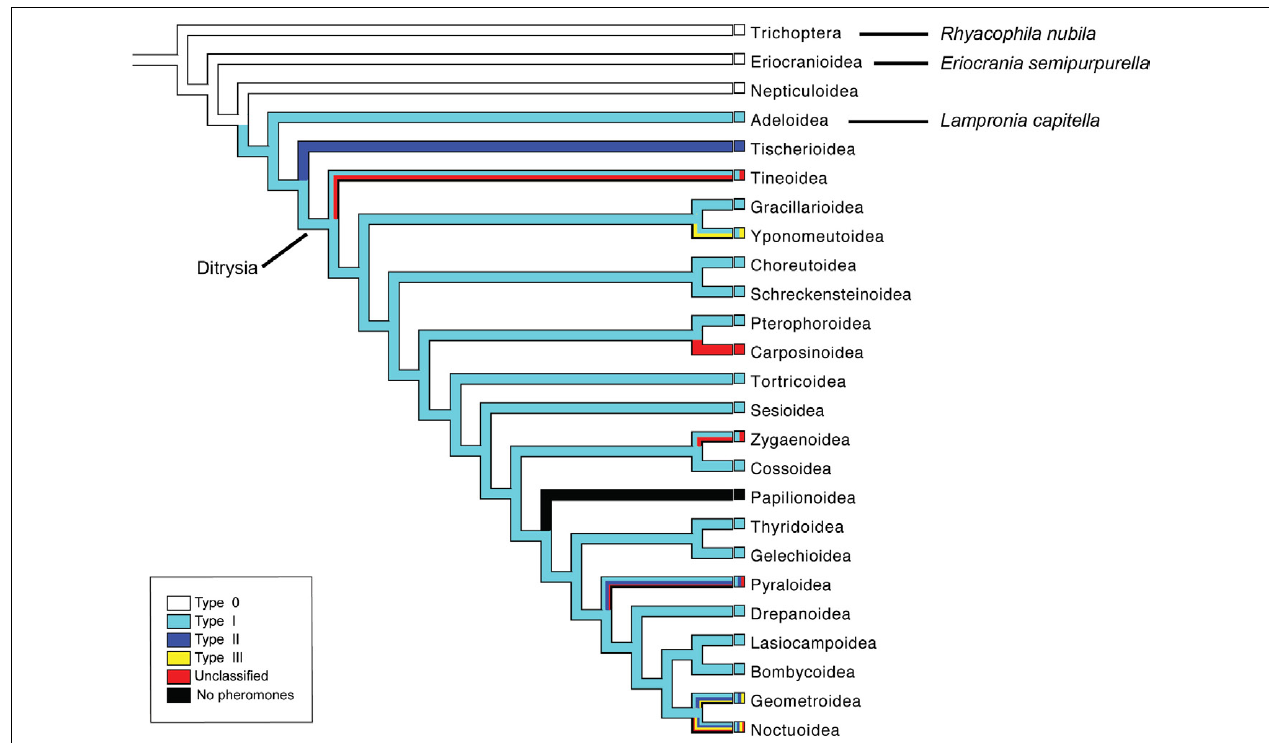
FIGURE 1 | Phylogeny of major lepidopteran superfamilies and the sister order Trichoptera with the suggested evolution of different sex pheromone types indicated by different colors on branches (adapted from Löfstedt et al., 2016). Except for the Papilionoidea, only taxa with identified female-produced sex pheromones or sex attractants are included. The figure is modified from Yuvaraj et al. (2017), with permission from the publisher (link to article: https://academic.oup.com/mbe/article/